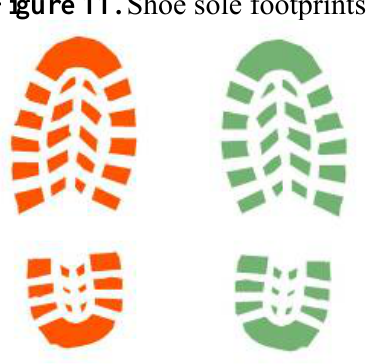
Figure 11. Shoe sole